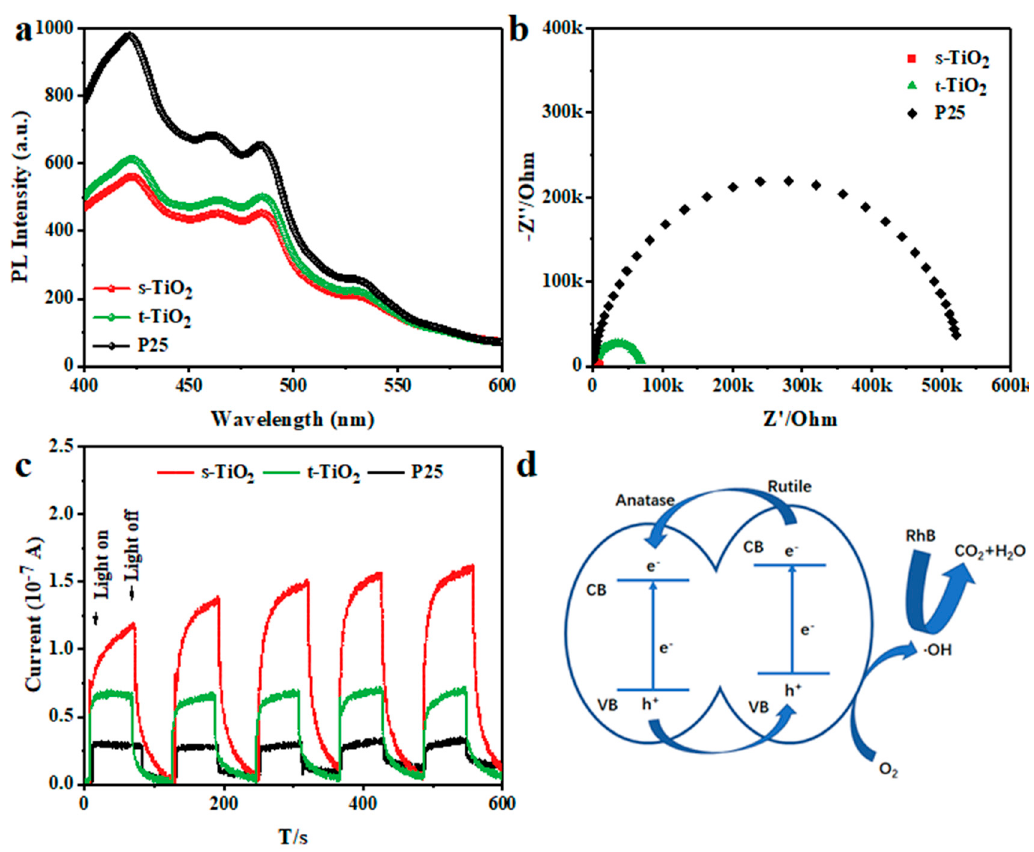
Figure 6. ( a ) PL spectrum, ( b ) EIS Nyquist plot, ( c ) photoelectrochemical responses, and ( d ) band structure alignments of s-TiO 2 and P25.